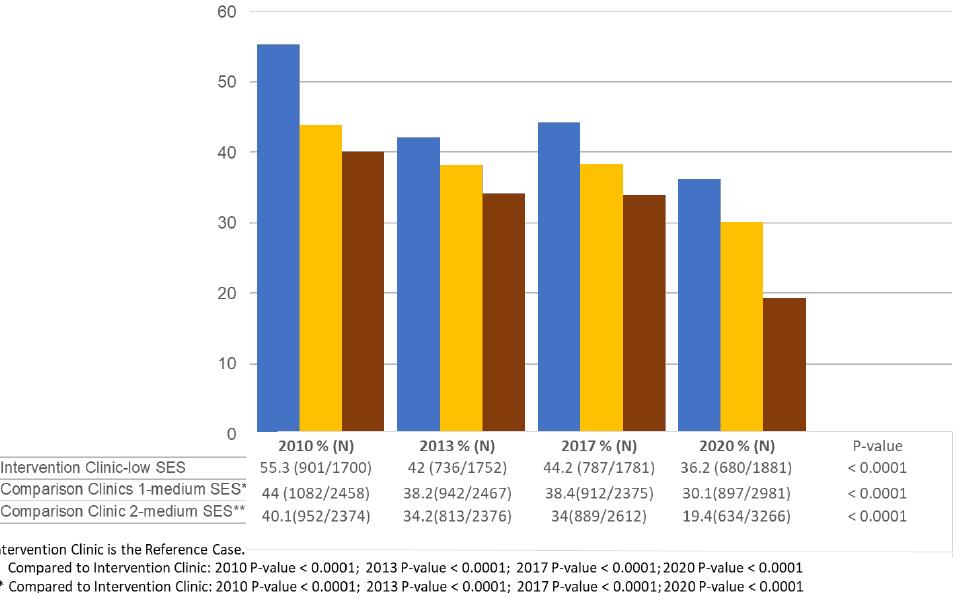
Figure 1. Mammography screening rates in the intervention and comparison clinics by